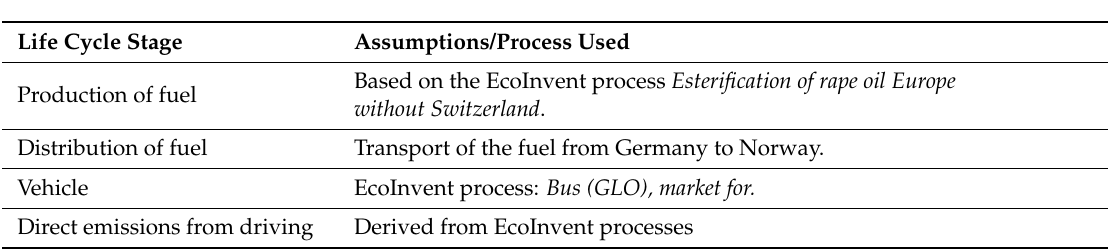
Table A7. Biodiesel FAME.